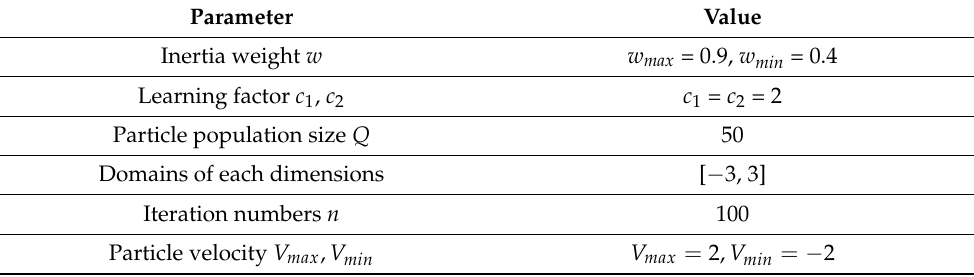
Figure 21. The variation trend of vertical force under particle swarm optimization method.